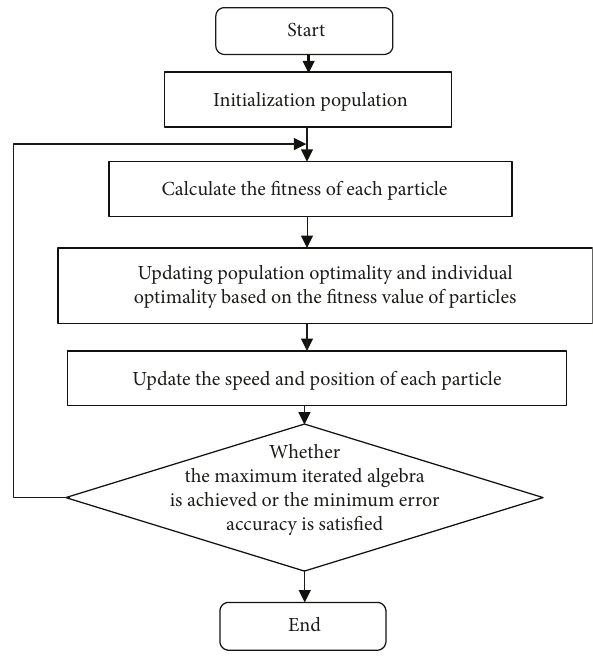
Figure 7: Flowchart of PSO